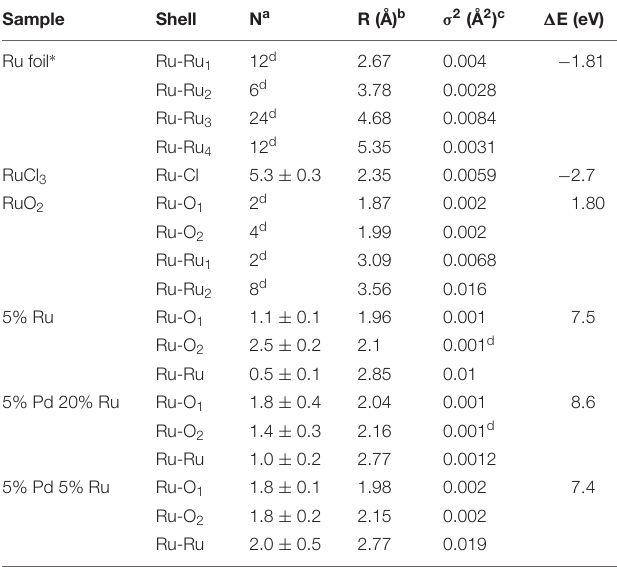
TABLE 3 | EXAFS structural parameters of the ruthenium foil, RuO 2 , RuCl 3 and biogenic Ru and Pd-Ru NPs samples